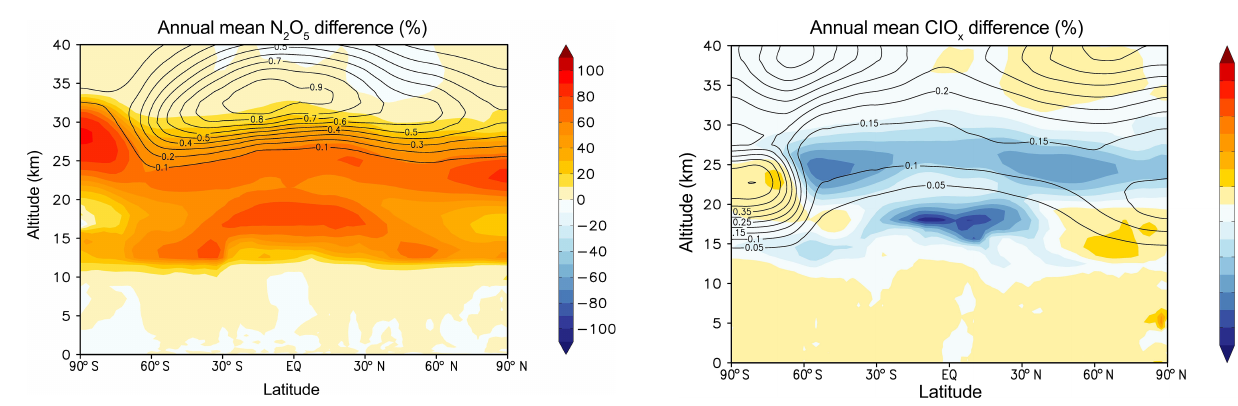
Figure 7. Simulated annual-mean, zonal-mean ClO x percentage differences between TiO 2 injection (S3) and the Mt Pinatubo erup- tion (S2). Black contour lines show ClO x mixing ratios from the Mt Pinatubo simulation (S2) in